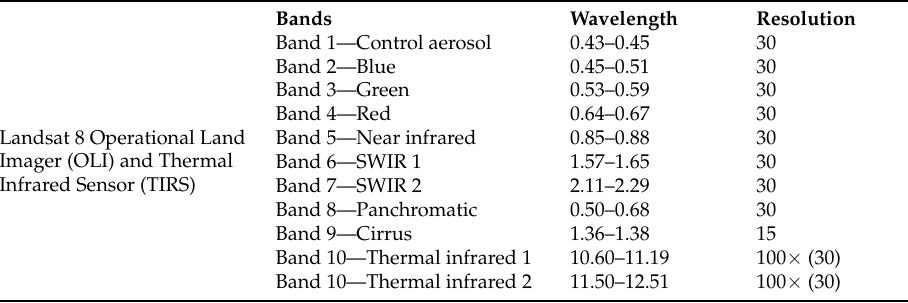
Table A1. Spectral characteristics of Landsat